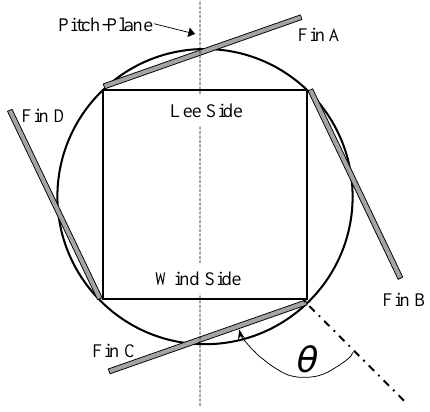
Fig. 7. Schematic showing orientation of Fins A through D relative to pitch-plane.